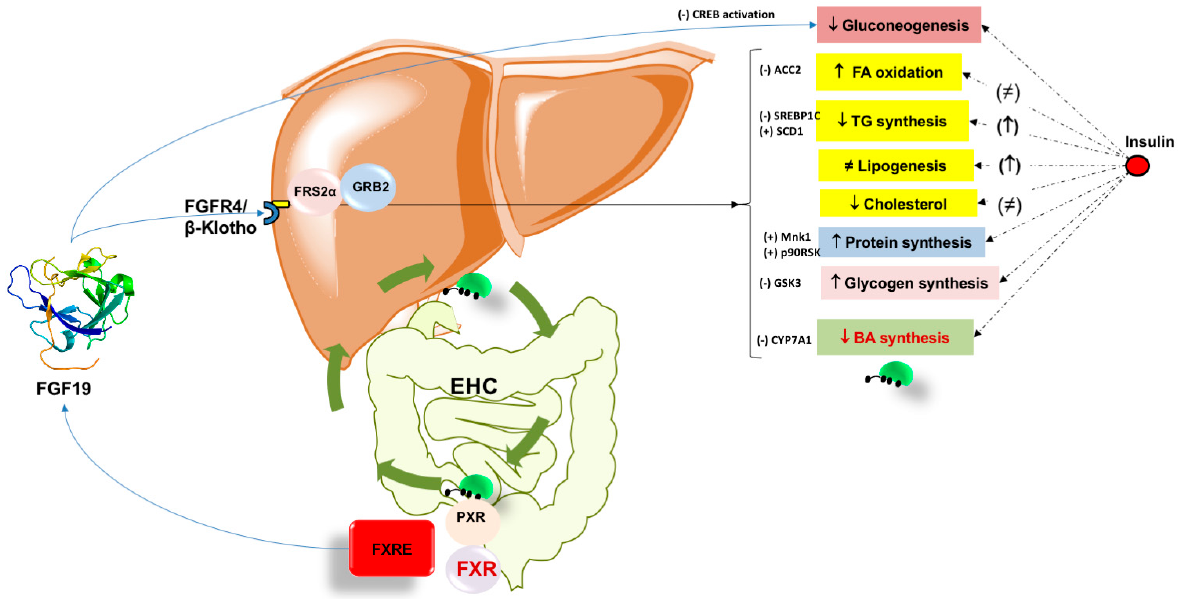
Figure 2. Summary of the metabolic effects of Fibroblast growth factor 19 (FGF19) in the liver. The role of insulin is shown for comparison. Bile acids during the enterohepatic circulation (EHC) activate intestinal FXR promoting FGF19 secretion. Circulating FGF19 signaling requires the presence of β -Klotho [ 279 ] which is the fibroblast growth factor receptor 4 (FGFR4) co-receptor required for liver-specific FGF19 actions [ 112 ] . The tissue-specific expression pattern of β -klotho and FGFR isoforms determines FGF19 metabolic activity [ 116 ] . In the hepatocyte, the signaling events allow the recruitment of cytosolic adaptors such as fibroblast growth factor receptor substrate 2 α (FRS2 α ) and growth factor receptor-bound protein 2 (GRB2). The ultimate metabolic effects of FGF19 are depicted on the right within the boxes, with major regulatory elements listed. Legend; ACC2, acetyl- CoA carboxylase 2; CYP7A1, cholesterol-7 α -hydroxylase; CREB cAMP-response element-binding protein; FXR, farnesoid X receptor; FXRE, FXR responsive element; GSK3, glycogen synthase kinase 3; Mnk1, protein kinase; p90 ribosomal S6 kinase; PXR, pregnane X receptor; PXRE, PXR response element; SCD1; stearoyl-CoA desaturase 1; SREBP1C, sterol regulatory element-binding protein 1C. (+) activation; (-) inhibition; ≠ , unchanged.